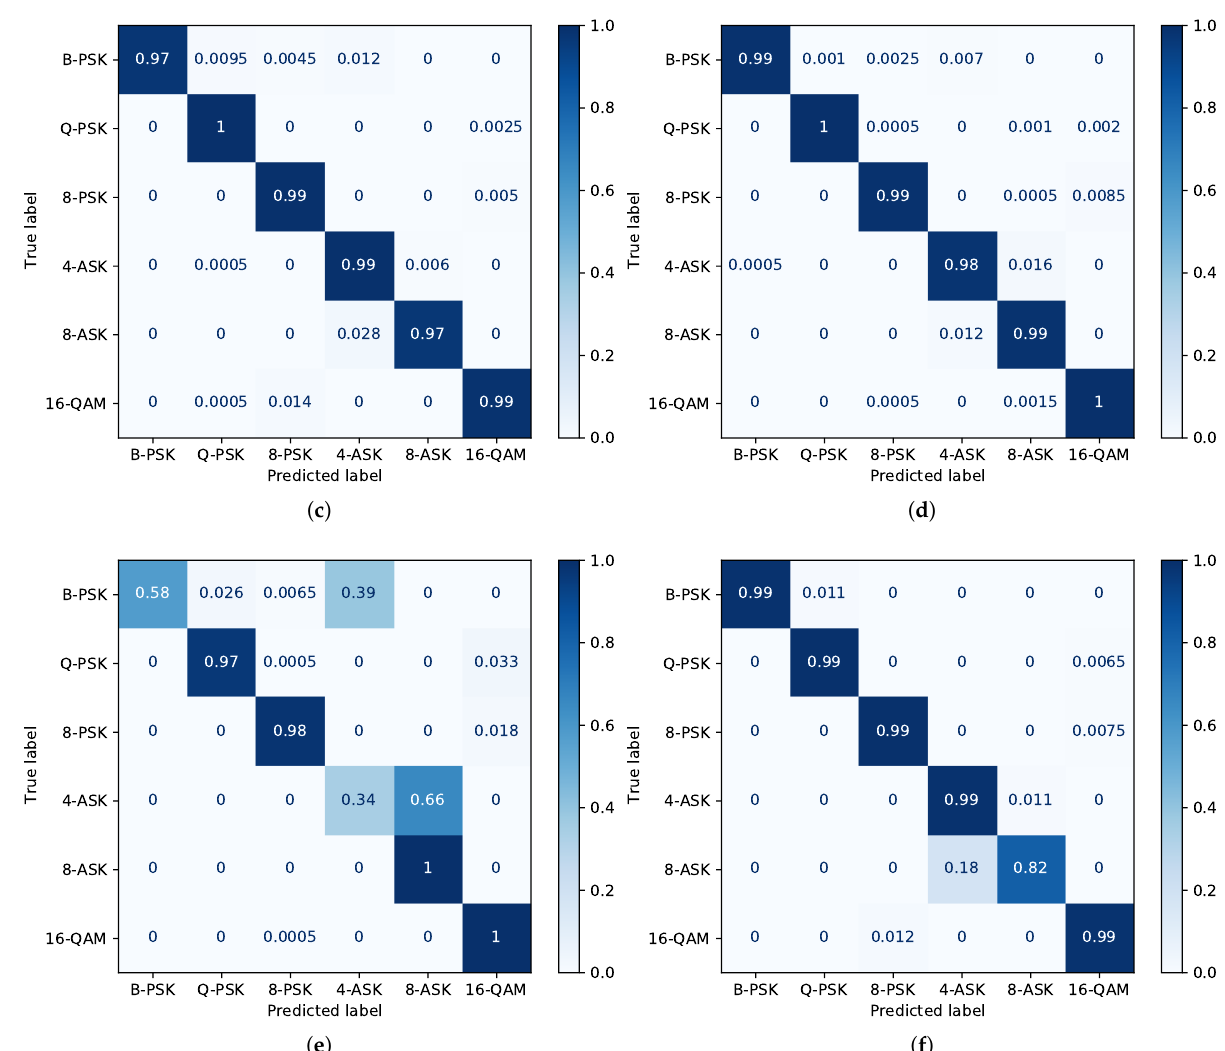
Figure 8. Confusion matrices given by ( a ) SSA, ( b ) STSSA, ( c ) IWSSA, ( d ) ISSA, ( e ) w/o FW, and ( f )